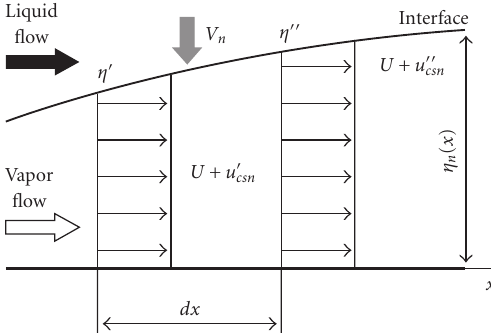
Figure 2: Control volume for continuity